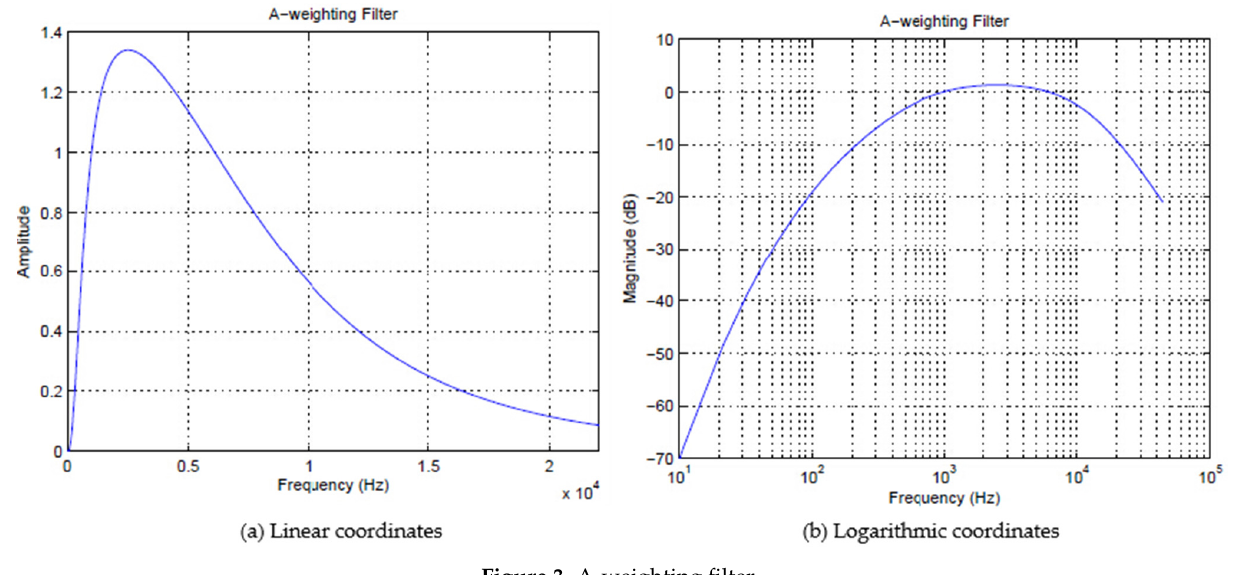
Figure 3. A-weighting filter.